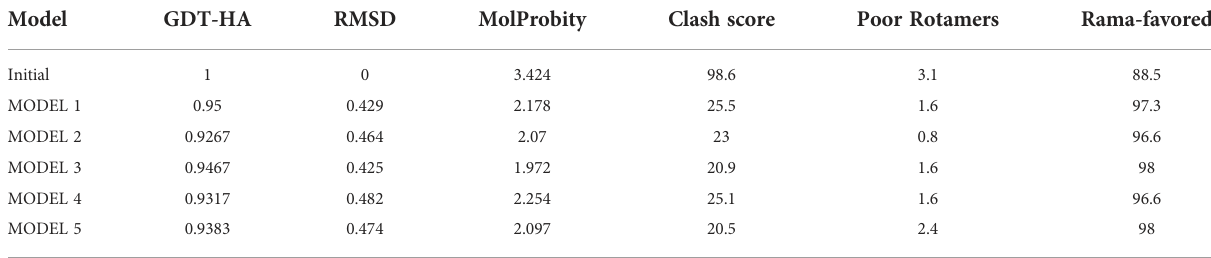
TABLE 3 Description of Galaxy Re fi ne ’ s improved structural